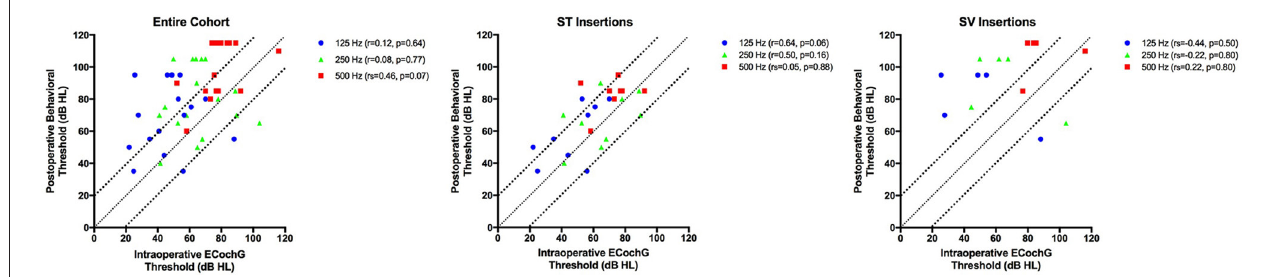
FIGURE 3 | The relationship between intraoperative ECochG thresholds, in dB HL, and postoperative behavioral thresholds, also in dB HL, for 125, 250, and 500Hz are depicted in the entire cohort, and for those cases in which scalar location is known. Bonferroni correction is applied for multiple comparisons, with p < 0.017 indicative of statistical significance. The diagonal and dotted lines represent the ± 20dB difference between ECochG thresholds and behavioral thresholds.